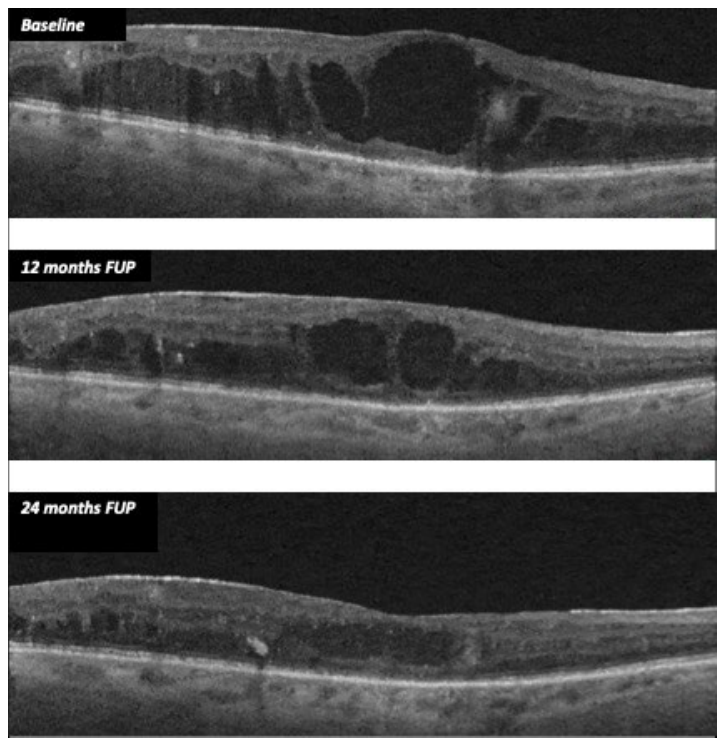
Figure 1. CMT variation during follow-up after FAc implant in case 11. Concerning electrophysiological measurements, PhNR amplitude varied from a mean value of 2.48 µV (± 1.05) at baseline, with a peak time of 61.05 ms (±7.03), to a mean value of 2.41 µV (± 1.03) at 24 months ( p = 0.797), with a peak time of 61.61 ms (±6.31) ( p = 0.8). B-wave amplitude showed a reduction from a mean value of 9.44 µV (± 5.65) at baseline, with a peak time of 39.46 ms (± 3.70) to a mean value of 7.51 µV (± 3.70) with a peak time of 37.61 ms (±10.23), albeit the results were not statistically significant ( p = 0.164). Age-matched healthy controls showed a mean B wave amplitude of 24 µV (SD 6.5) and a mean PhNR amplitude of 7 µV (SD 6.5).